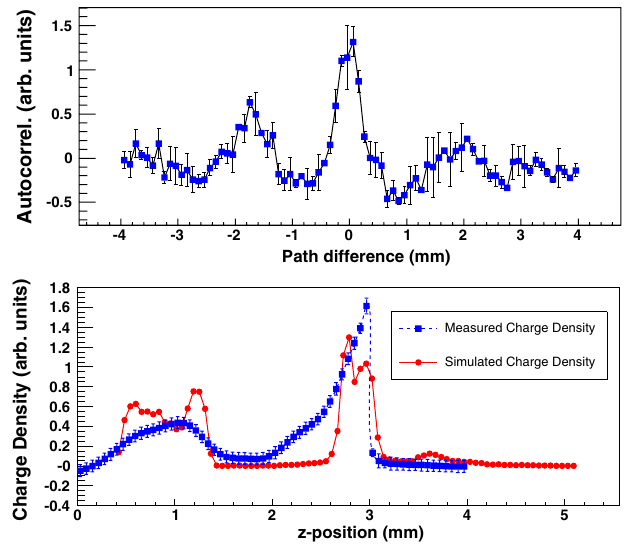
FIG. 8. (Color) Autocorrelation function (top) for electron bunches consisting of two pulses separated by 15 ps before the bunch compression. Each pulse had about 0.5 nC. Maximum compression was set to occur at a position located between the two pulses and closer to the leading one. Longitudinal charge distributions from experiment (red line) and simulation (blue line) are shown in the bottom plot. For these settings of the photoinjector, the overall compression factor is about